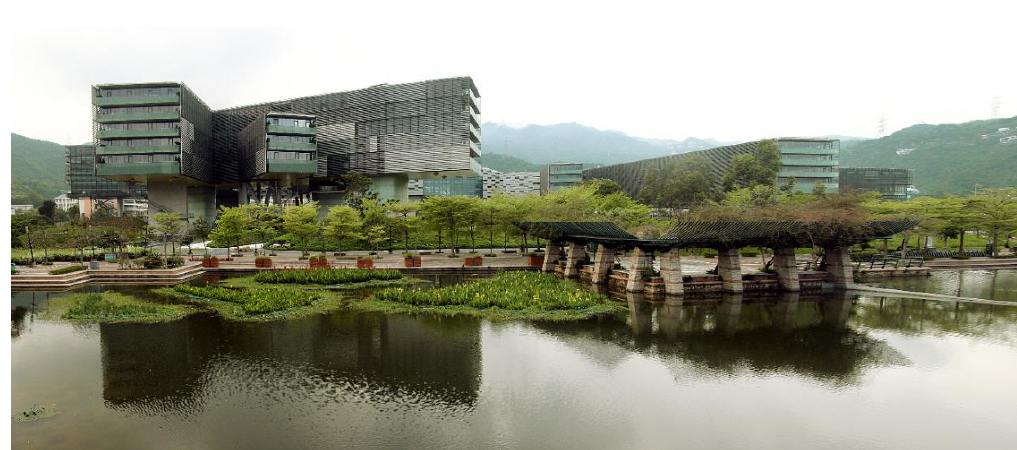
Figure 4. Vanke Center in Shenzhen, China, an example of a “groundscraper”. Photo by trevor.patt (Flickr), licensed under CC BY-NC-SA 2.0.